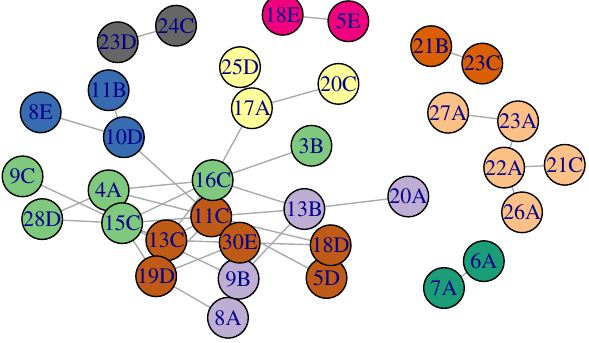
FIG. 5. Communities detected in the FCI correlation matrix with r > 0 . 2 . Each community is drawn in a different